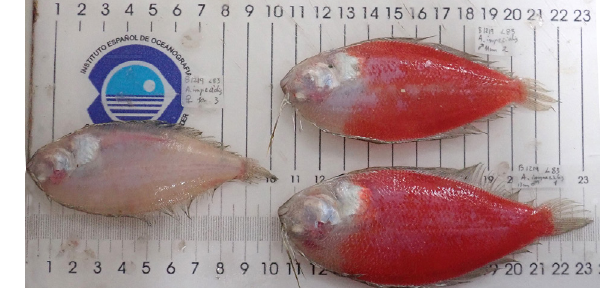
Fig. 3. – Arnoglossus blachei Stauch, 1965, B1219, L83, one female (left) and two males (right), Guinea-Bissau. Photographs of fresh specimens taken by Pere Oliver Reus. Ocular side.